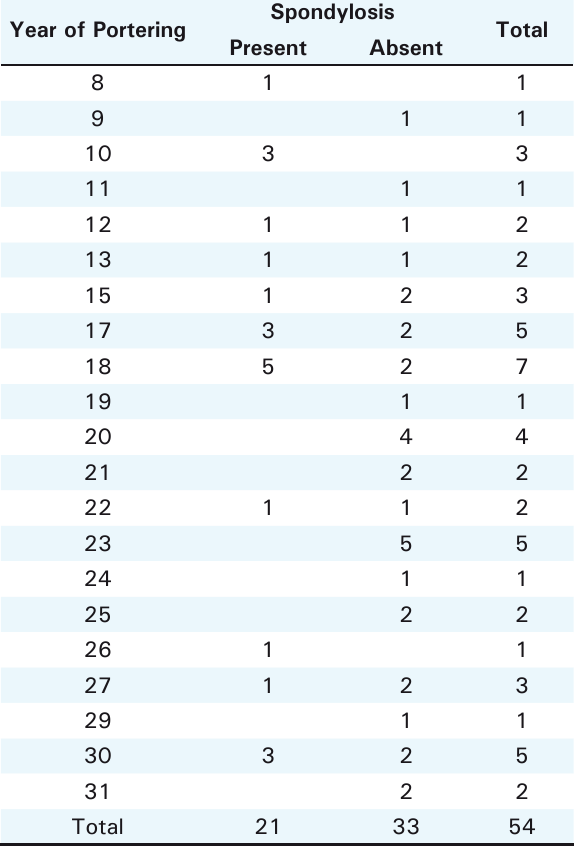
table 7. Spondylosis against the year of portering.